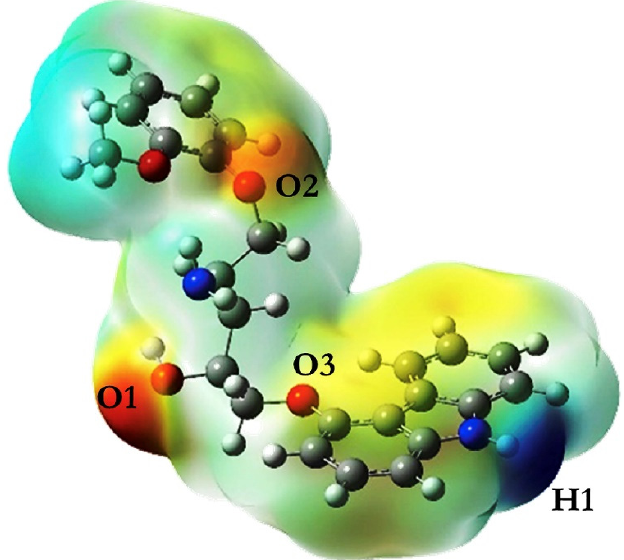
Figure 4. Electrostatic potential energy diagram of endotoxin in template (Reprinted with permission from [106]. Copyright 2019 Elsevier).